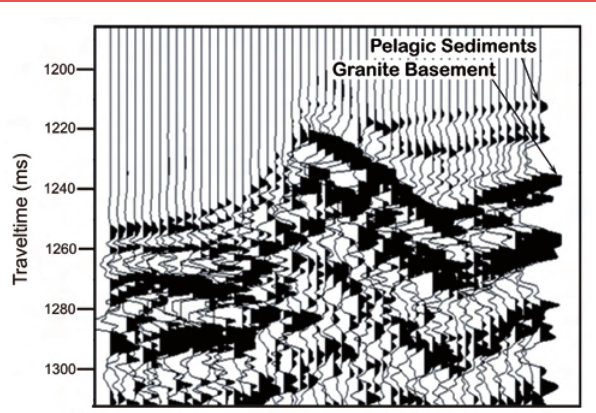
Figure 5. Unprocessed single-fold seismic reflection data from Mackay Sea Valley (MSV) seismic survey in Granite Harbor showing low-amplitude sediments overlying a high-amplitude granite basement. The high-amplitude reflection that appears to be a basement step could instead be caused by a terminal moraine. Trace spacing is 50